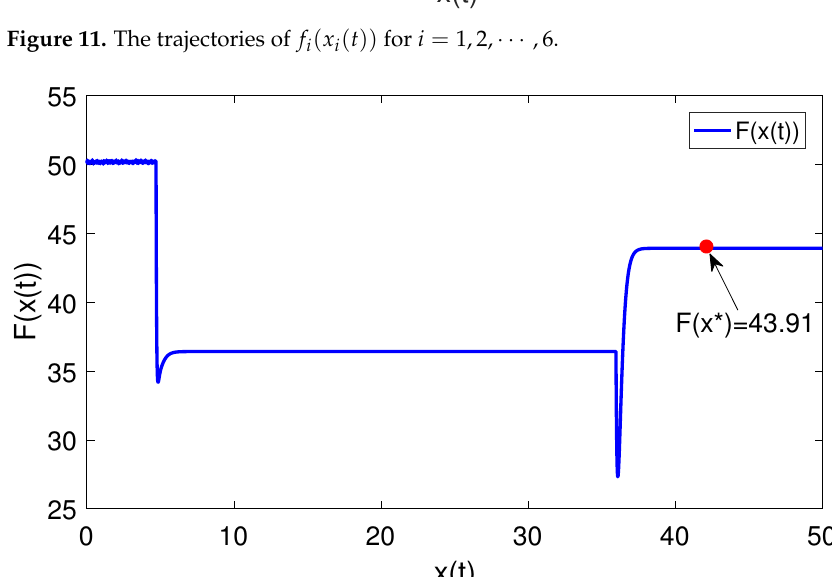
Figure 11. The trajectories of f i ( x i ( t )) for i = 1,2, · · · ,6.